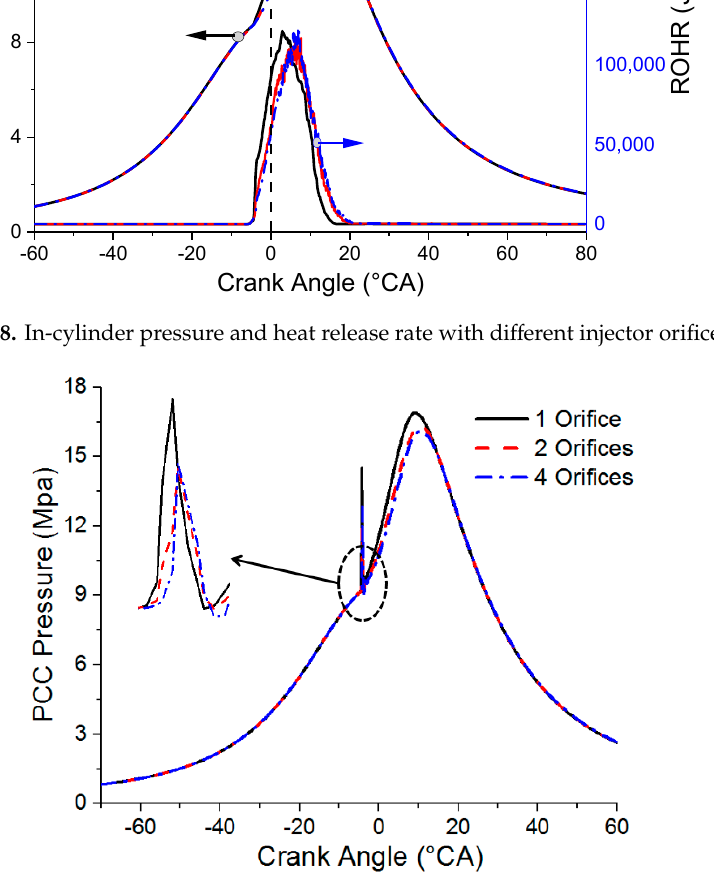
Figure 9. Mean in-cylinder pressure with different injector orifices.